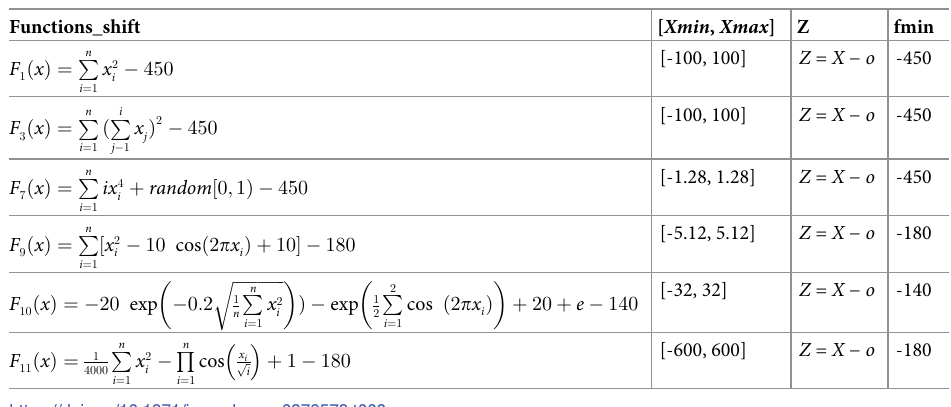
Table 8. Shift test